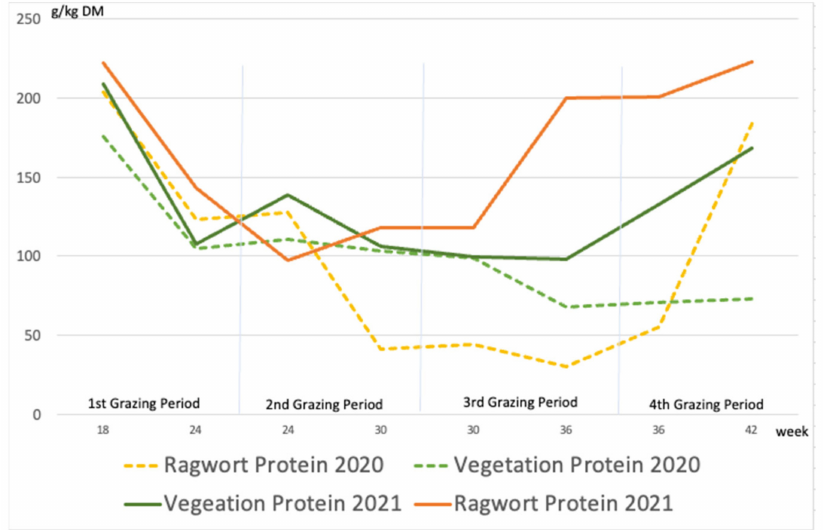
Figure 4. Content of crude protein (g/kg DM) in ragwort and other plants (“vegetation”) during the experiment.